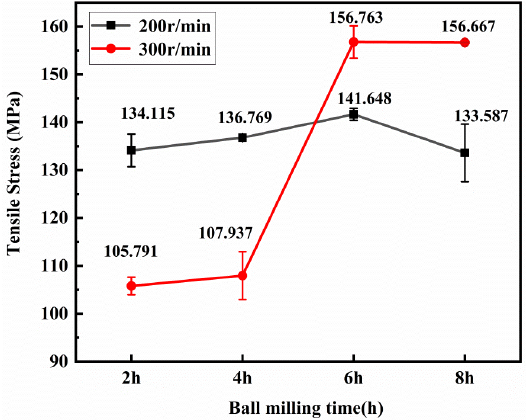
Figure 14. Tensile strength of the composite.